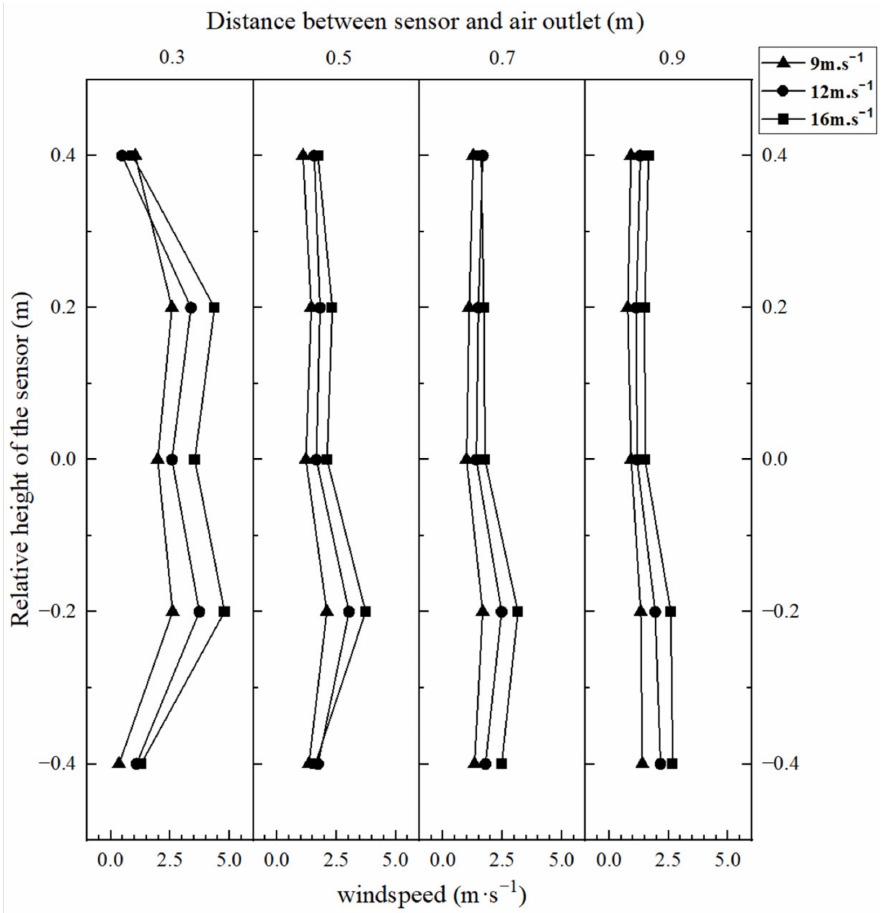
Figure 7. The static wind field of the air-assisted spray unit at different outlet wind